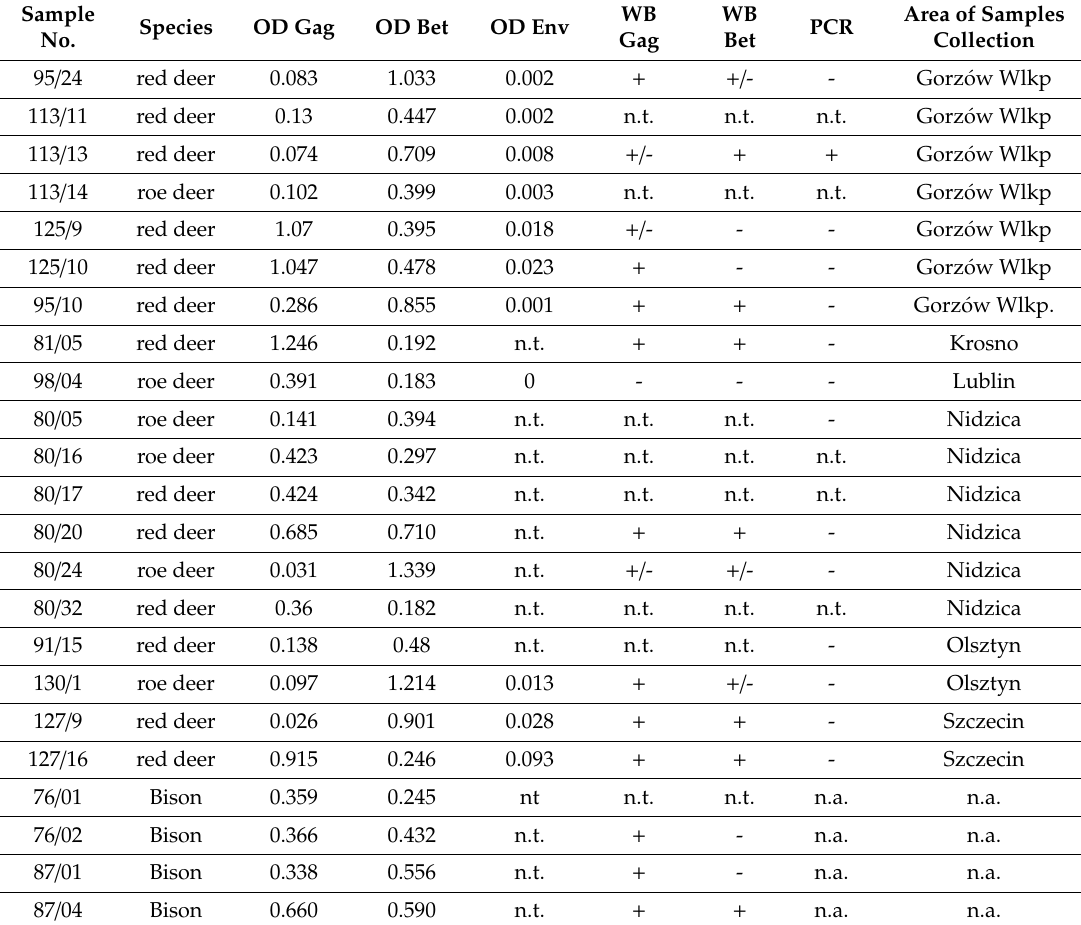
Table 1. Summary of Gag and Bet ELISA, western blotting (WB), and PCR